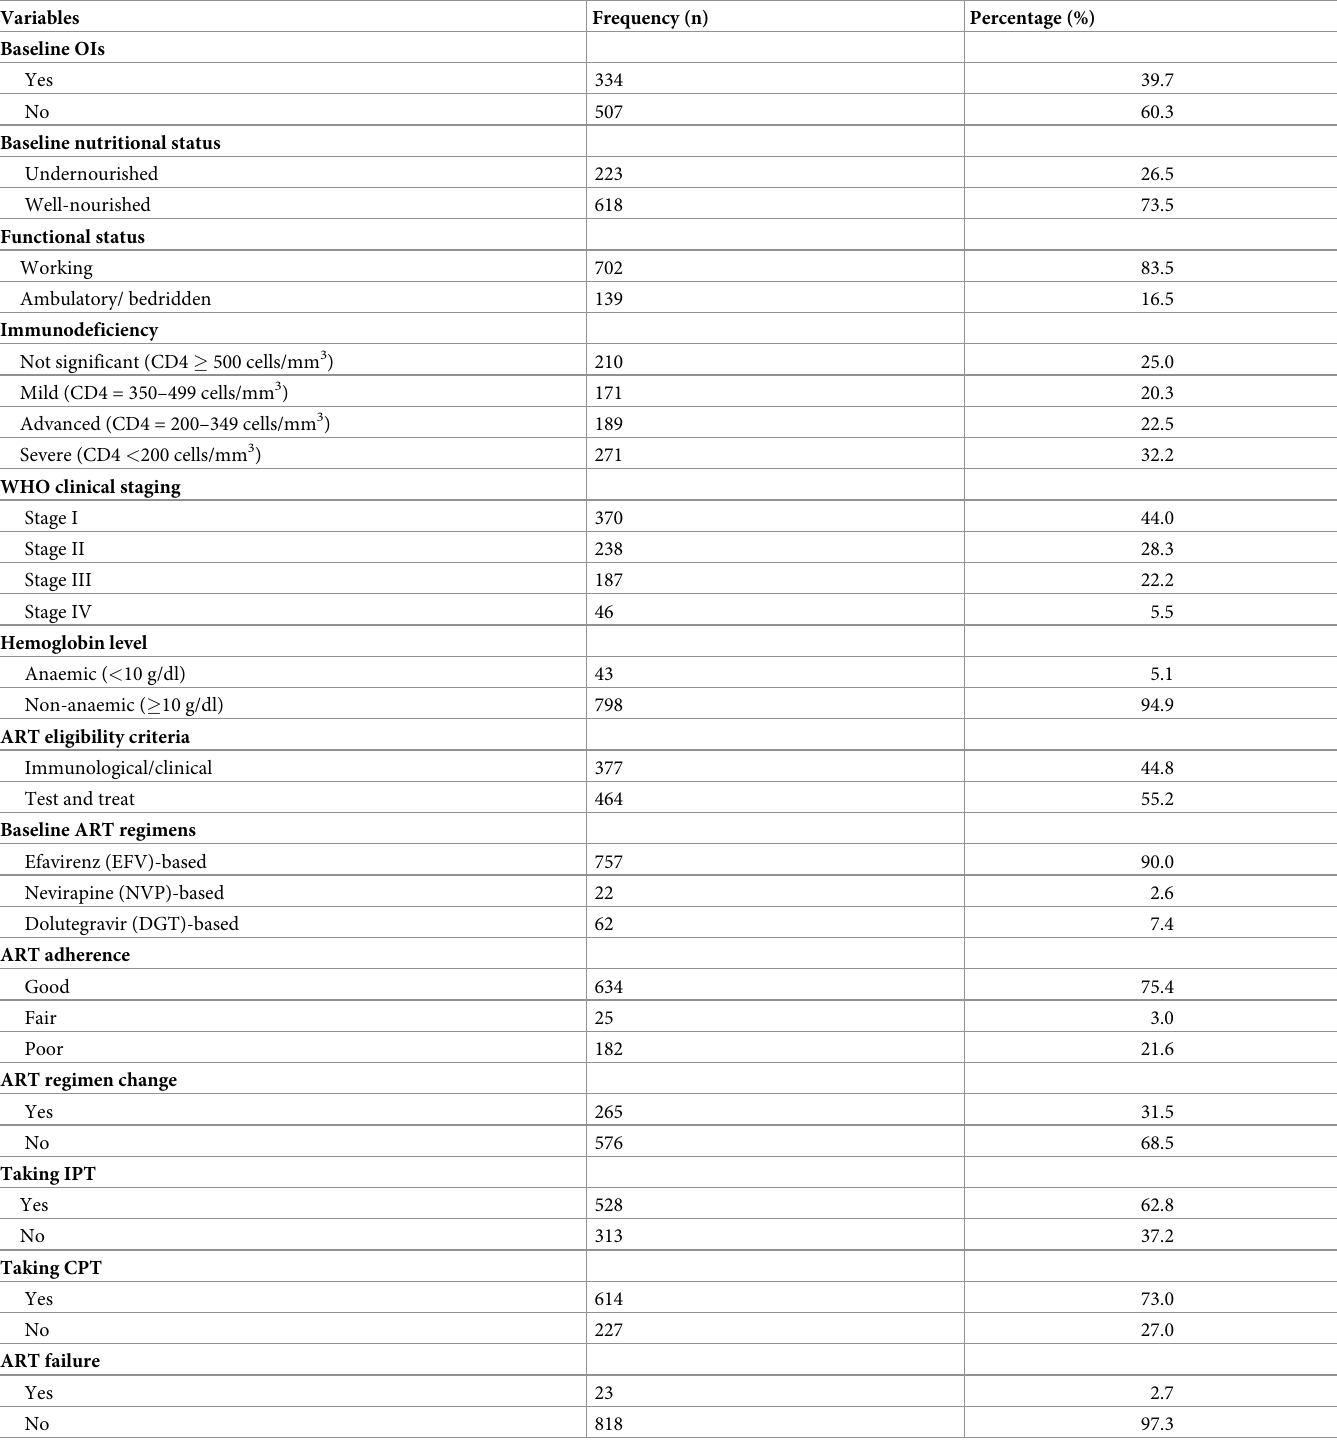
Table 2. Clinical characteristics of participants at Debre Markos Comprehensive Specialized Hospital, Northwest Ethiopia (n =